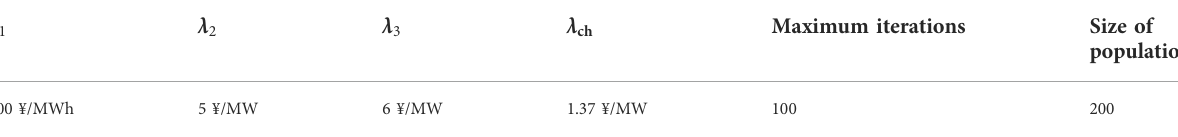
TABLE 3 Input parameters of